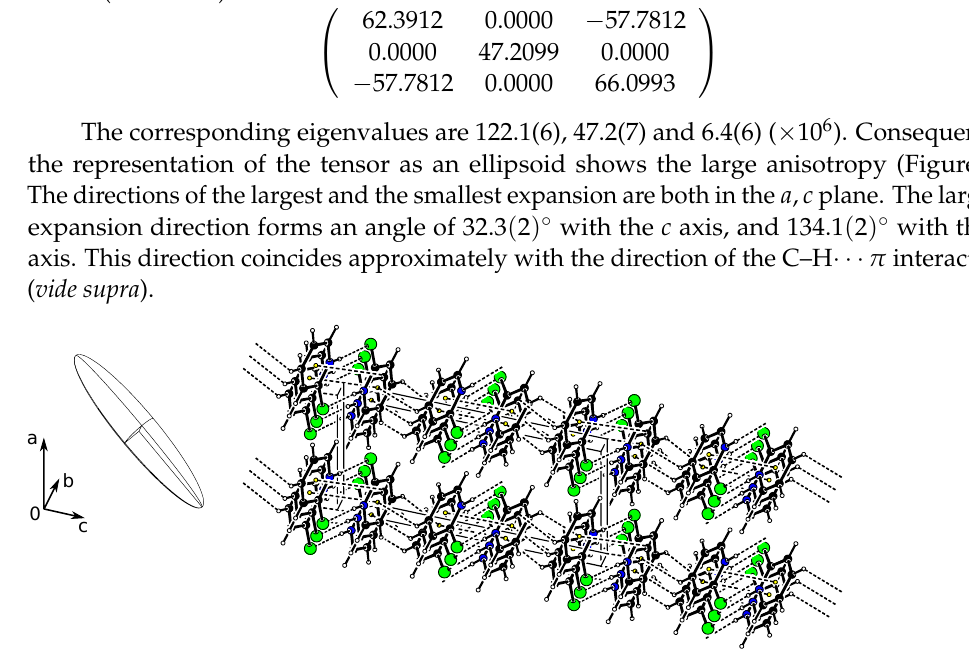
Figure 4. Two-dimensional layers formed by weak intermolecular interactions in the b , c plane are stacked in the direction of the a axis. The intermolecular interactions are drawn as dashed lines. The ellipsoid of the anisotropic thermal expansion tensor is drawn on an arbitrary